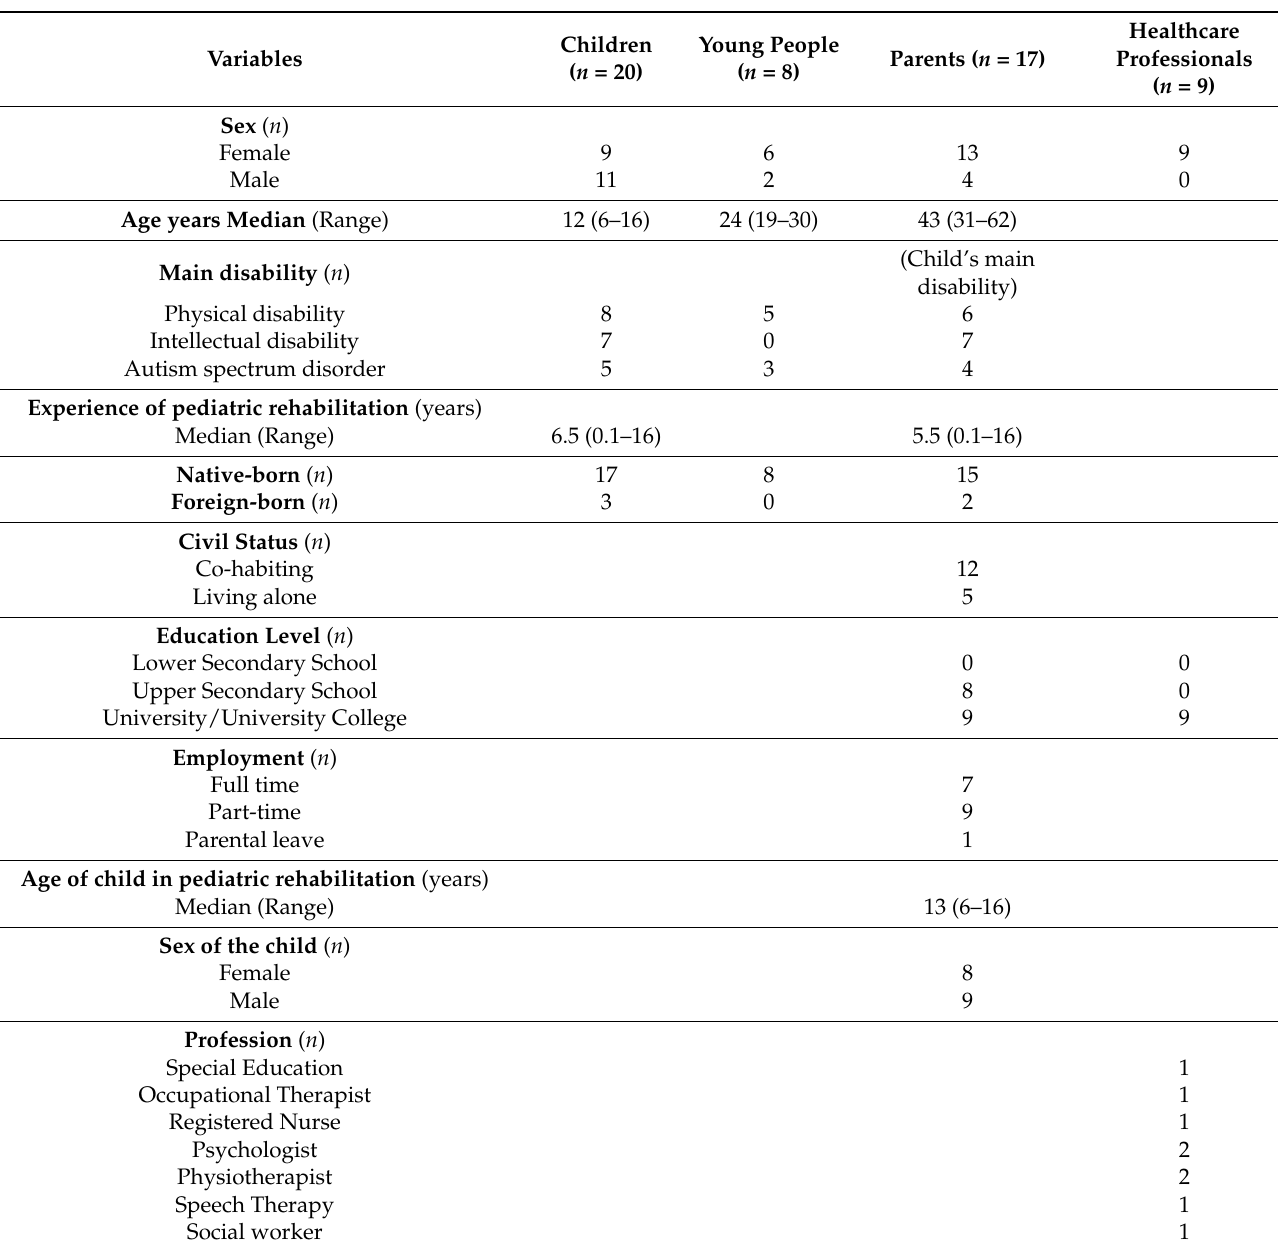
Table 1. Demographic and sociodemographic data of